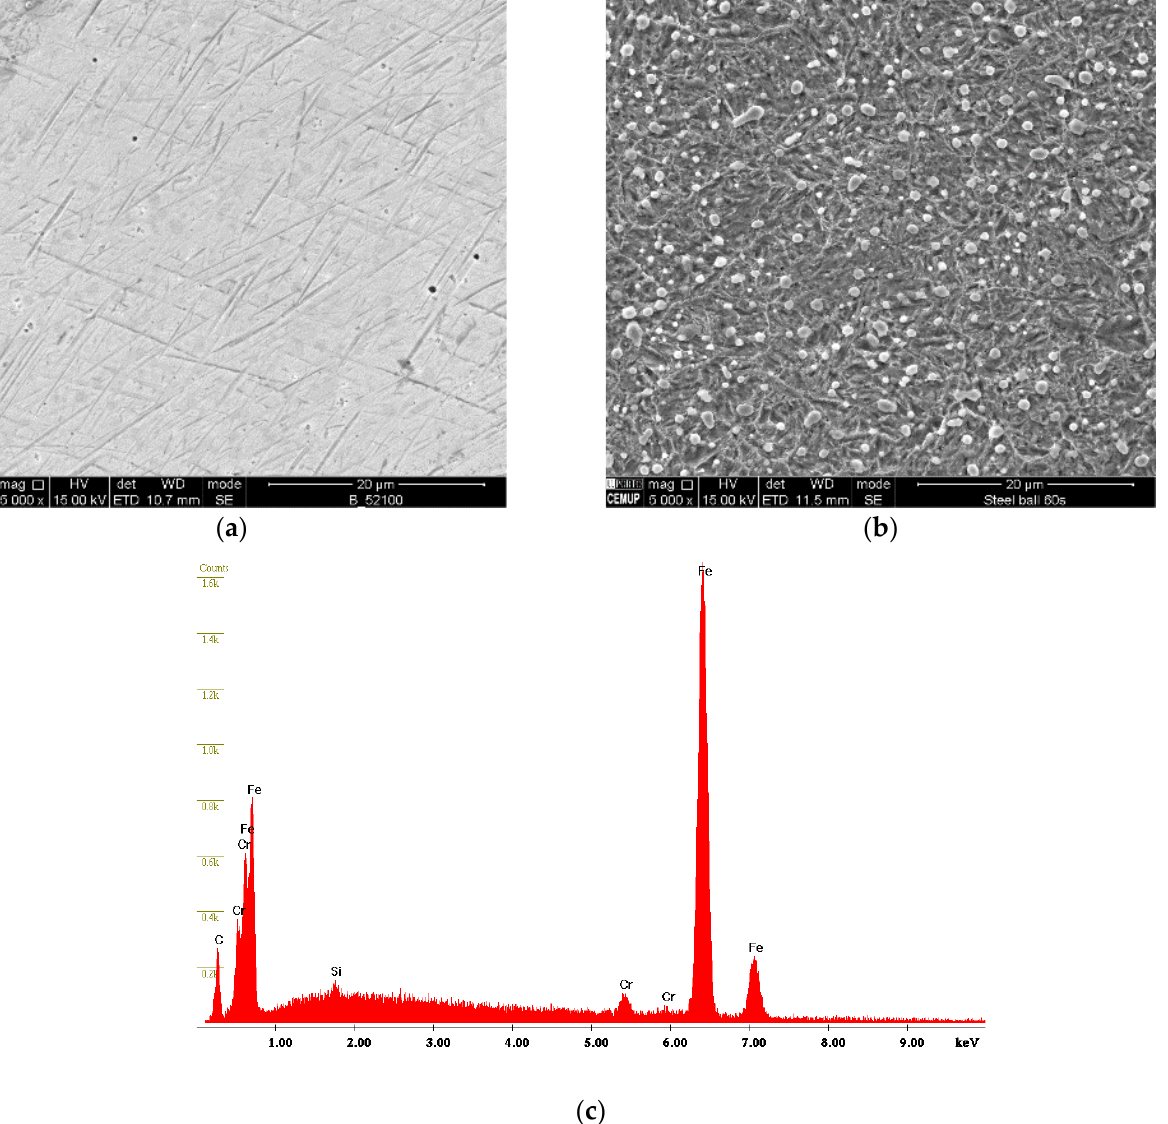
Figure 1. Ball surface morphology of: ( a ) as received ball, ( b ) etched ball in a 4% Nital solution for 60 s, and ( c ) EDS spectra of the polished ball.